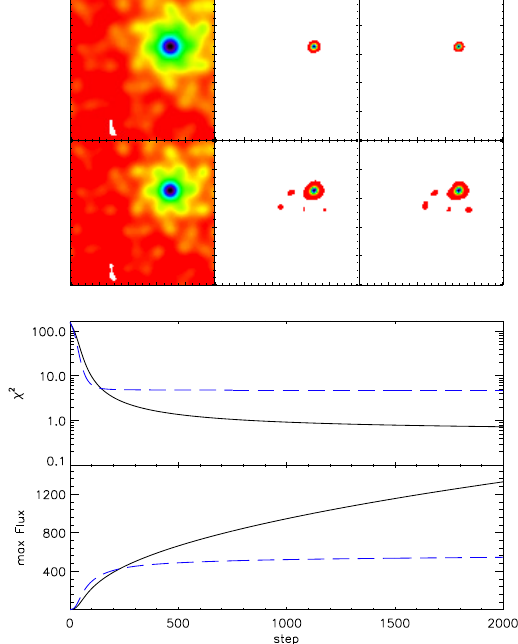
Figure 11. The plots present differences between square and rectan- gular transmission calculations. Top panel presents single source reconstructed with rectangular (top row), and square (bottom row) transmission functions. In addition, in the bottom panel, we show the χ 2 (top row) and source flux (bottom row) change with iteration steps. Values for square transmission are marked with blue dashed line while the rectangular ones are present with solid black lines.